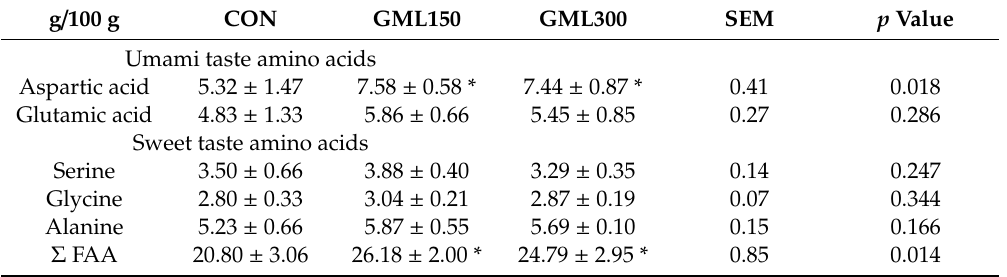
Table 3. E ff ect of dietary GML on albumen amino acids profile of late laying period hens. g / 100